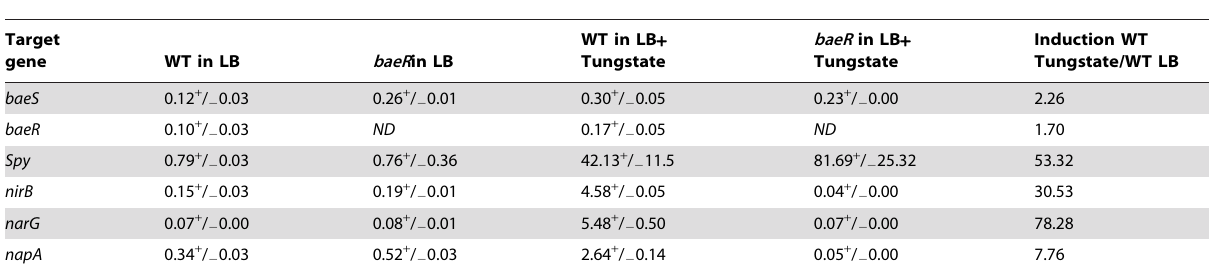
Table 1. Real time quantitative PCR on selected target genes.